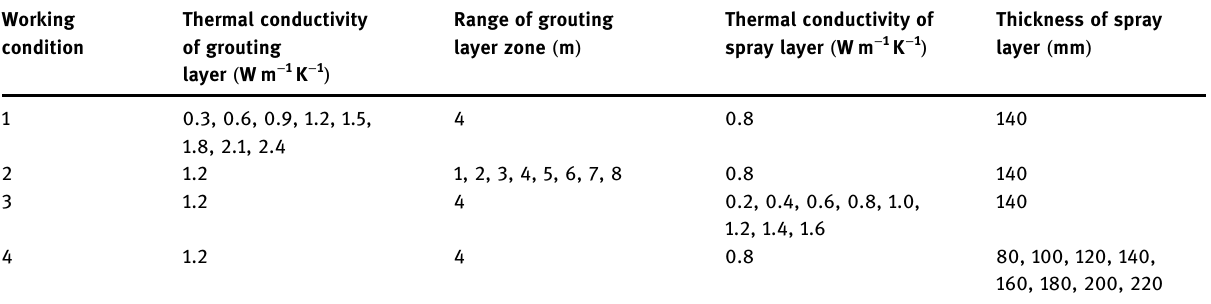
Table 1: Basic parameters and range variation of the working condition in the numerical test Working